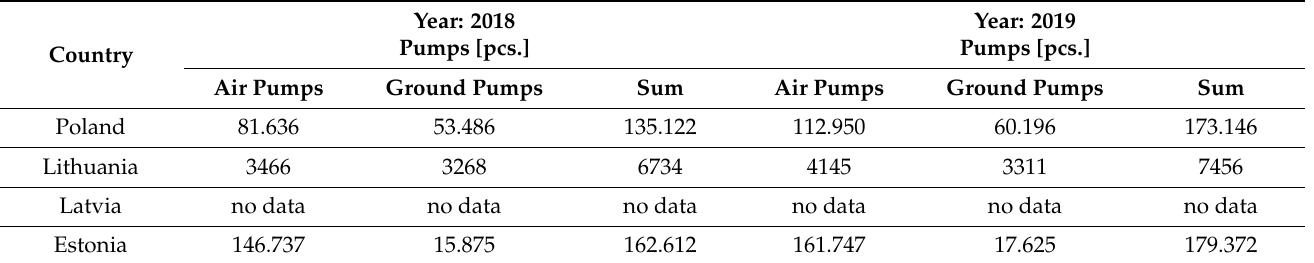
Table 3. Market analysis of heat pumps in use in Poland and selected Baltic States in 2018–2019 [pcs.] [28].